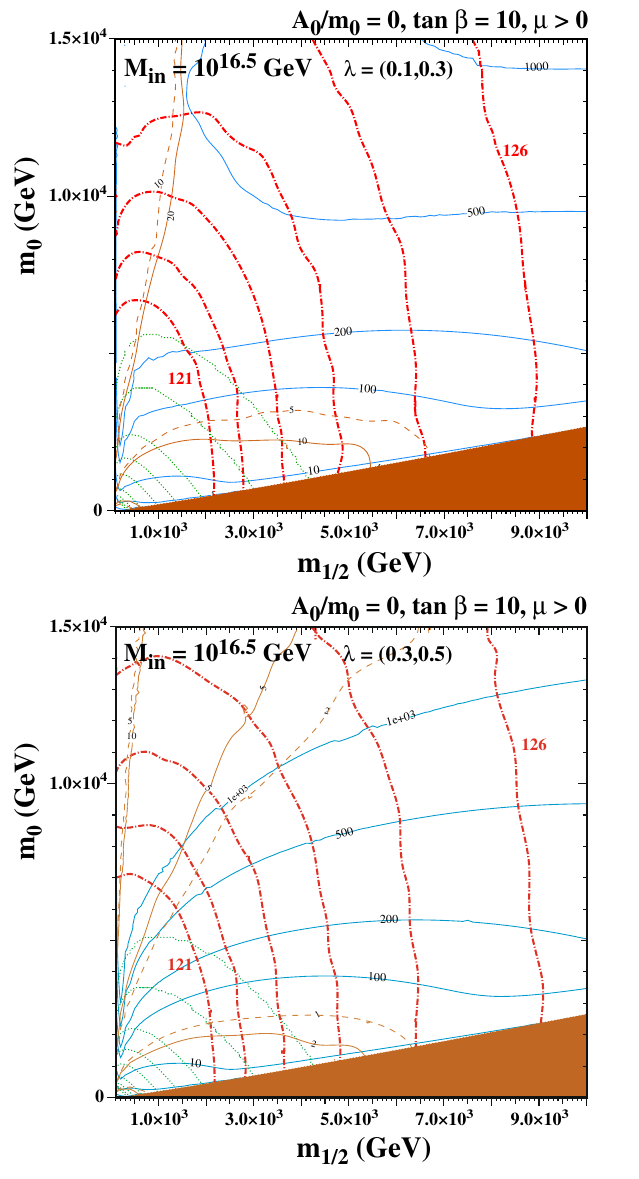
and λ = (0.5,0.5) (bottom right). Regions with a stau LSP are shaded brown. The contours are as in Fig.